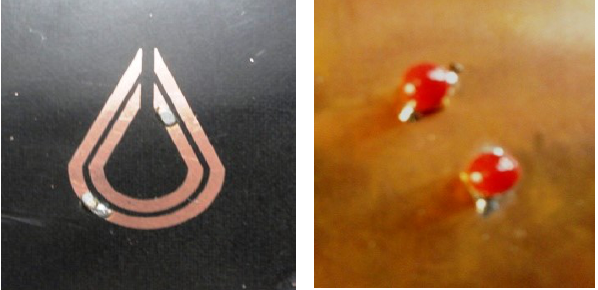
Figure 11: Fabricated prototype of proposed